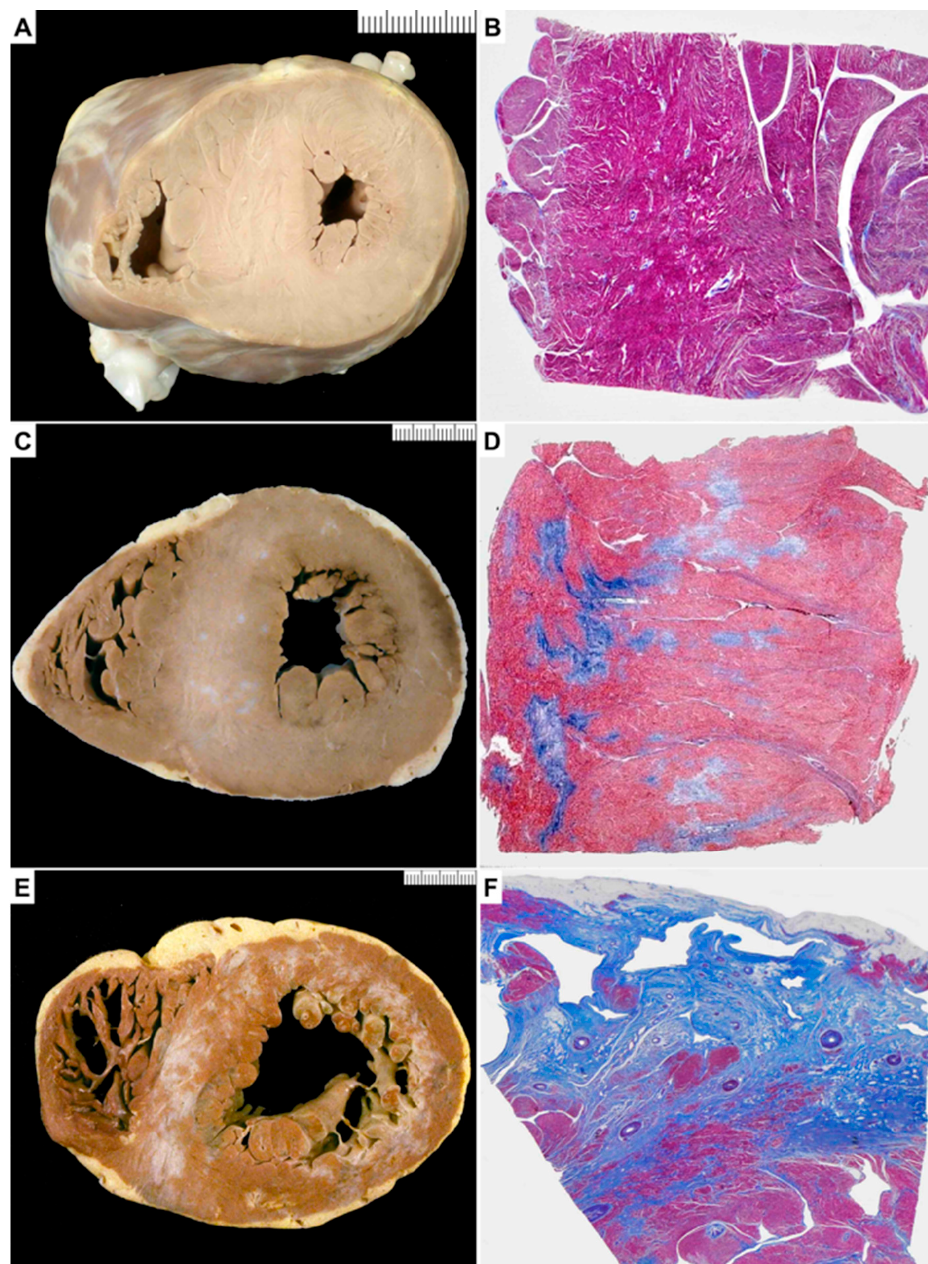
Figure 2. Gross and histological analysis of HCM hearts with different clinicopathologic phenotypes. ( A , B ) SCD-HCM patient with massive septal hypertrophy, without evidence of replacement-type fibrosis both grossly and histologically. ( C , D ) SCD-HCM patient with grossly evident scars at the level of the IVS, confirmed by histology. ( E , F ) HF-HCM patient with thinning of the LV free wall and IVS due to widespread scarring, confirmed at histology as replacement-type fibrosis associated with small vessel remodeling. ( B , D , F ) Heidenhain trichrome, panoramic view. (b) Explanted native hearts of HCM patients with end-stage HF. Ten consecutive cases (mean age 51.60 ± 13.21, range 22–68; 4 males, 40%) who underwent HT for end-stage HF-HCM were enrolled. Heart weight ranged from 350 to 620 g (mean 425.70 ± 96.99 g) and with a mild rise of 44.40 ± 29.57% compared to the mean normal weight value for sex and age. The mean thickness of the IVS was 14.7 ± 3.09 mm, LV free wall 12.11 ± 2.02 mm, and RV free wall 4.77 ± 2.10